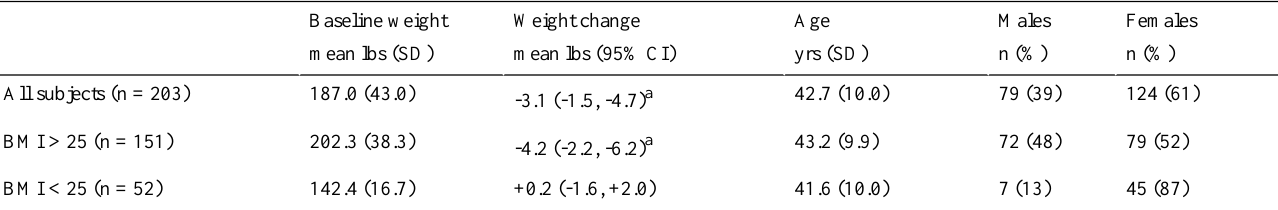
Table 2. Weight change from baseline to 12